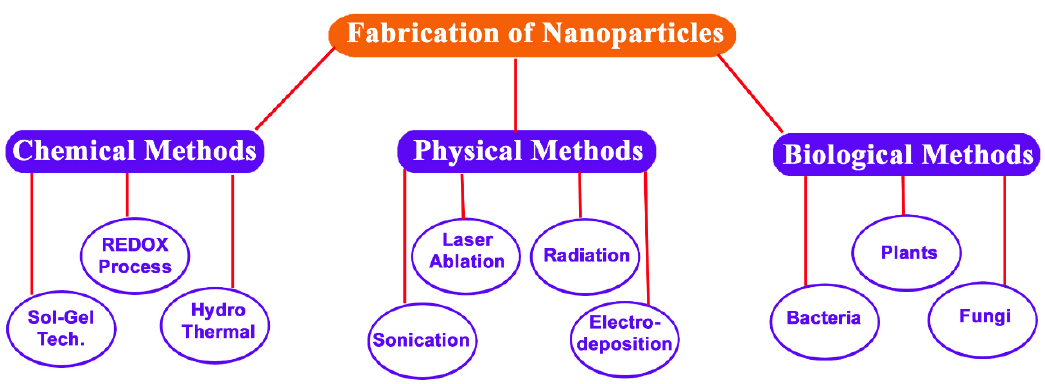
Figure 1. Schematic presentation of various methods used in the synthesis of metal NPs.